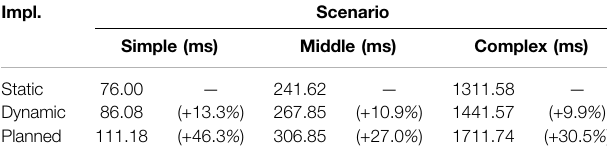
TABLE 4 | Averaged results of the runtime overhead experiment per scenario.